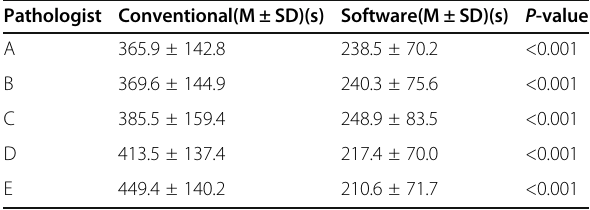
Table 1 Comparison of the time of each pathologist using conventional assessment and software-assisted assessment of the tumor bed after neoadjuvant